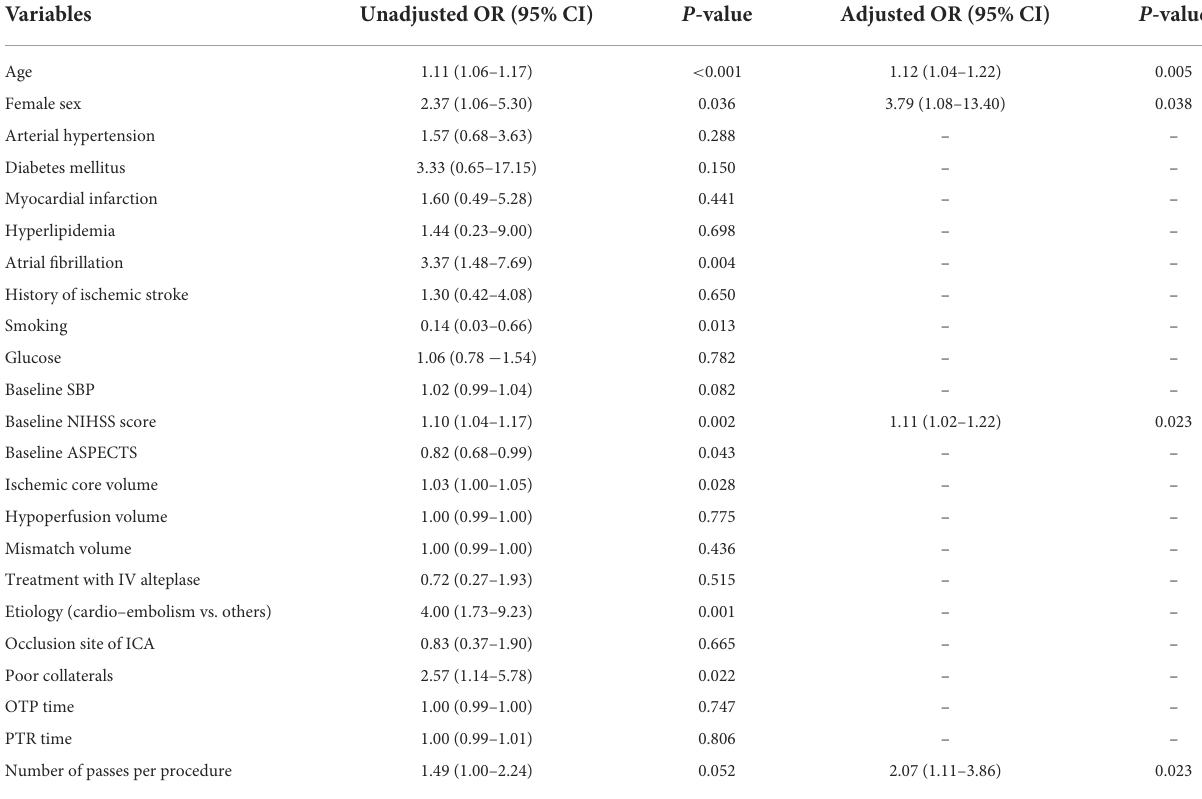
TABLE 2 Logistic regression analysis identifying the risk factors associated with futile recanalization.